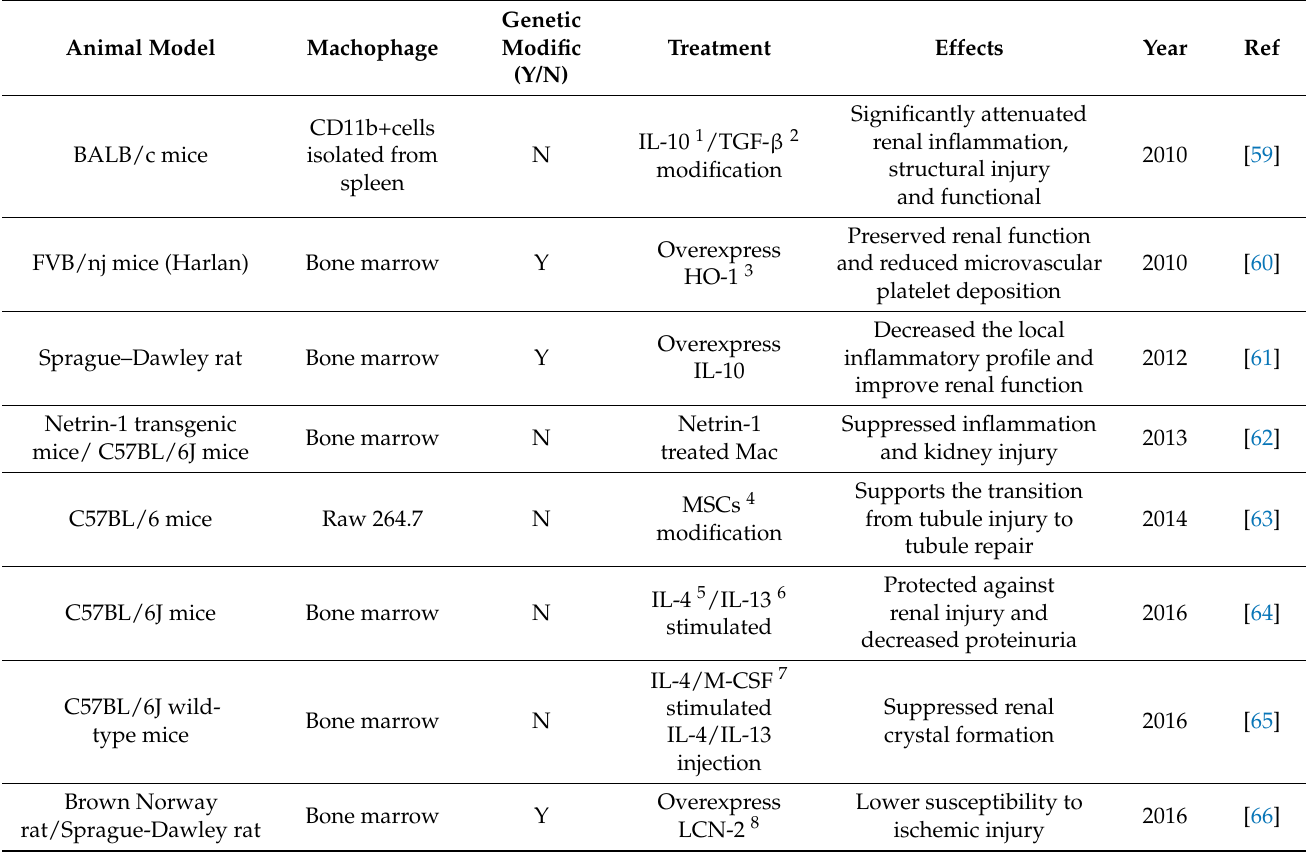
Table 1. Cell therapies with M2-induced